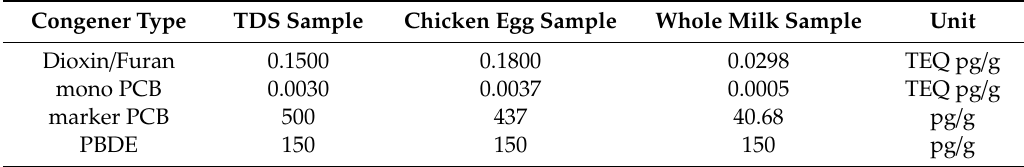
Table 1. Objectives of sample upper